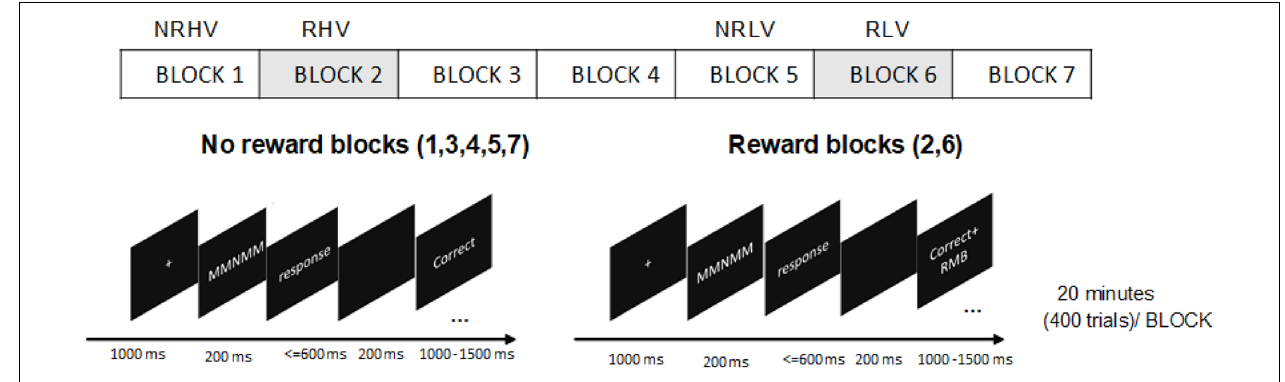
FIGURE 1 | The procedure of experiment design and the trial structure of flanker